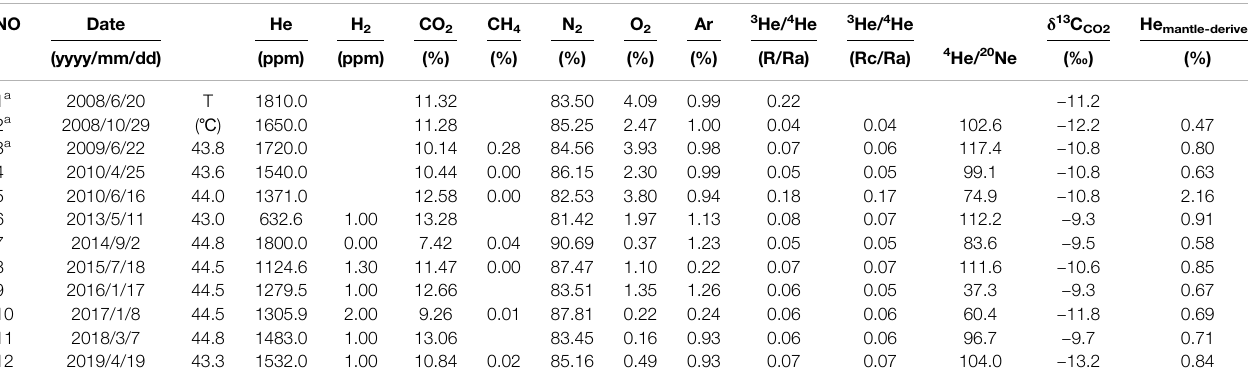
TABLE 1 | Gas and isotopic compositions of the Luojishan hot